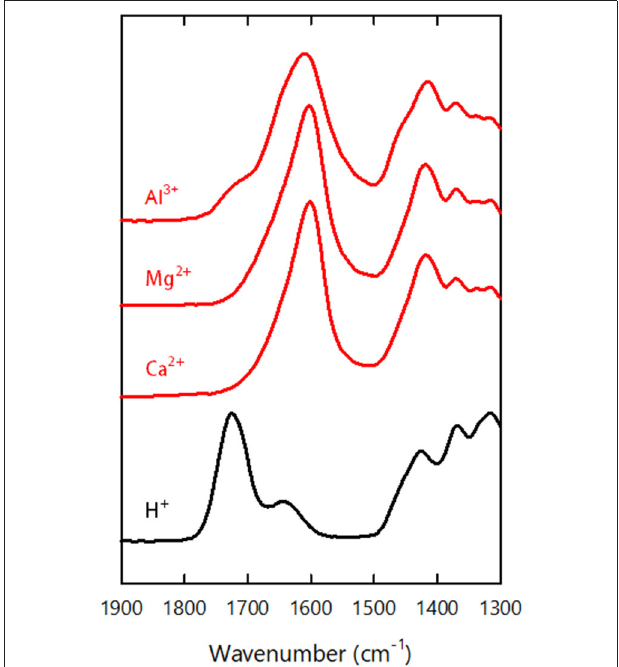
FIGURE 3 | FTIR spectra of the h -xerogel, h - Ca -xerogel, h - Mg -xerogel, and h - Al -xerogel.